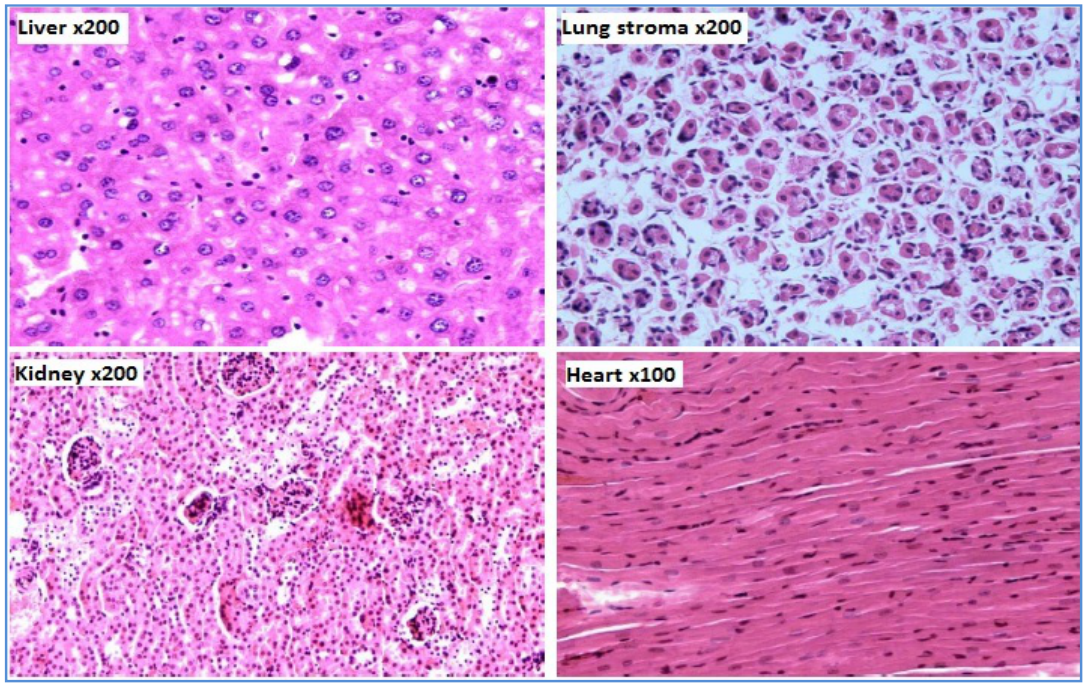
Figure 2. Photomicrographs of the sections of the liver × 200, lung stroma × 200, kidney × 200 and heart × 100 showing normal features in mice treated with 5,000 mg/kg of methanol extract of Piper betle leaves.